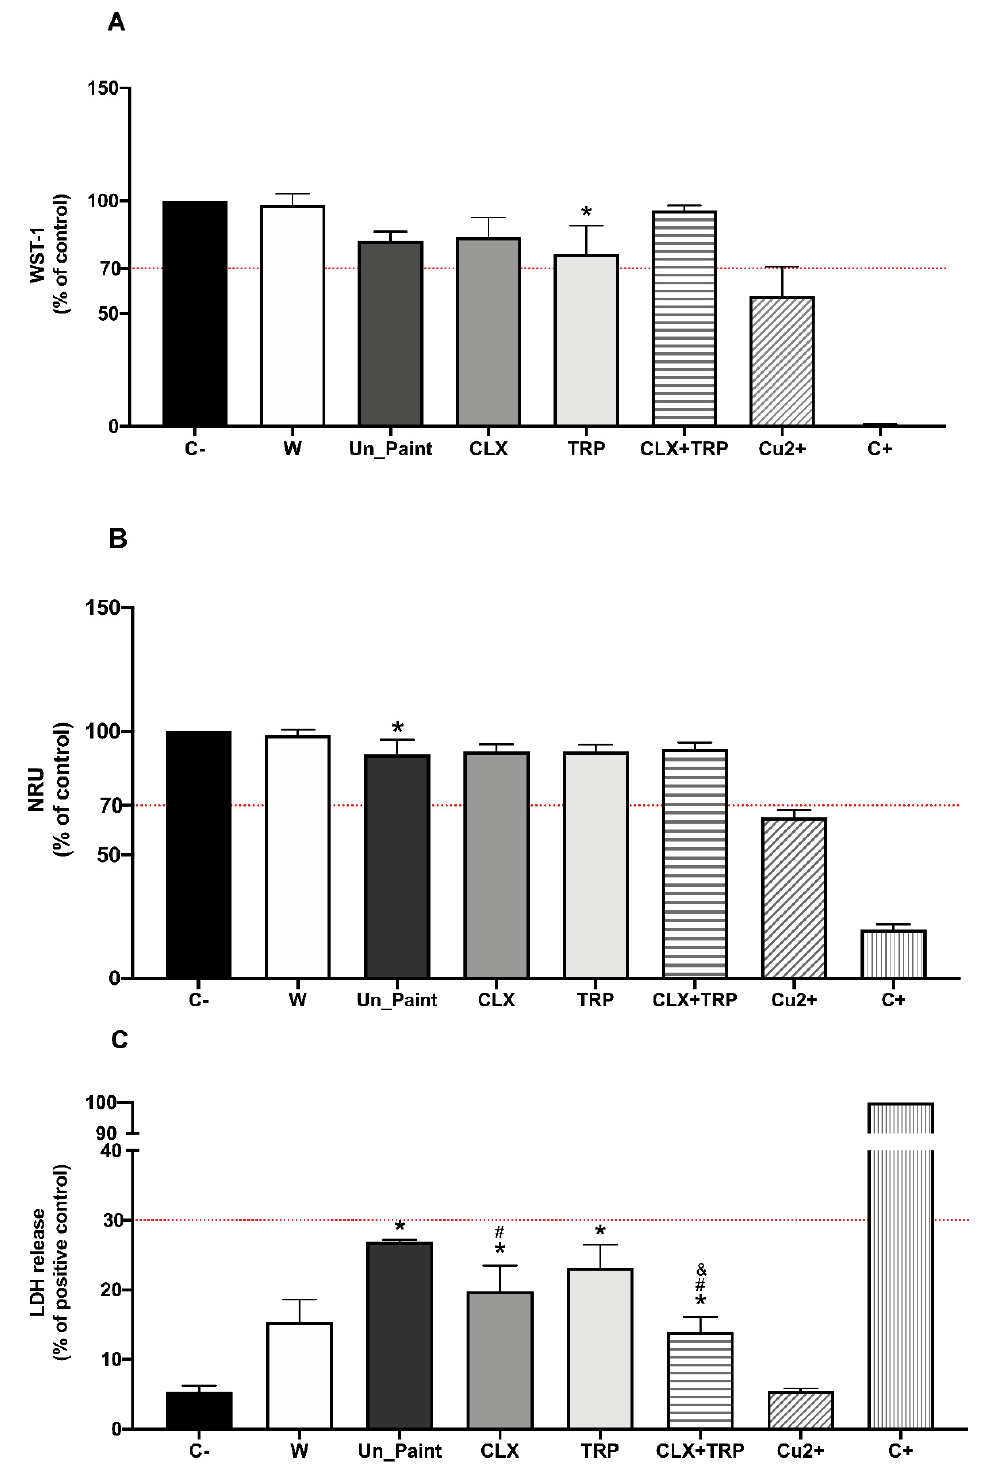
Figure 4. Results of WST-1 ( A ), NRU ( B ), and LDH ( C ) assays, with HaCaT cells, after 24 h of direct contact with Un_Paint, CLX, TRP, CLX+TRP, transparent polymeric film (W), and Copper (Cu 2+ ). C − negative control (assay medium), C+ positive control (Triton X-100 solution (1%) for WST-1 and LDH, or SLS 0.2 mg/mL of NRU). The red lines represent the defined thresholds of acceptable values for each parameter, 70% for cellular viability and 30% for LDH leakage. The values are expressed as mean ± standard deviation. The statistical significance of samples compared to C − is represented by *, the statistical differences compared to Un_Paint are represented by #, and the statistical differences compared to TRP are represented by &. (One-way ANOVA; p <